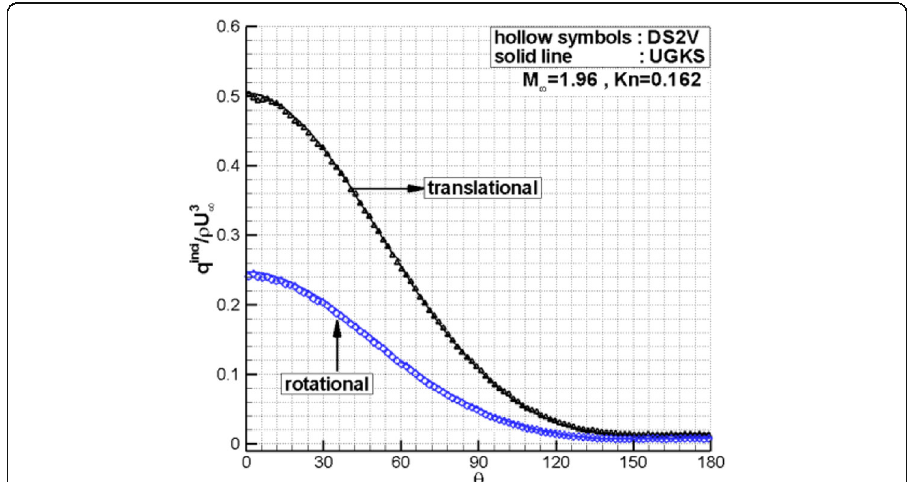
Fig. 14 Incident heat flux distributions on the cylinder surface at M =